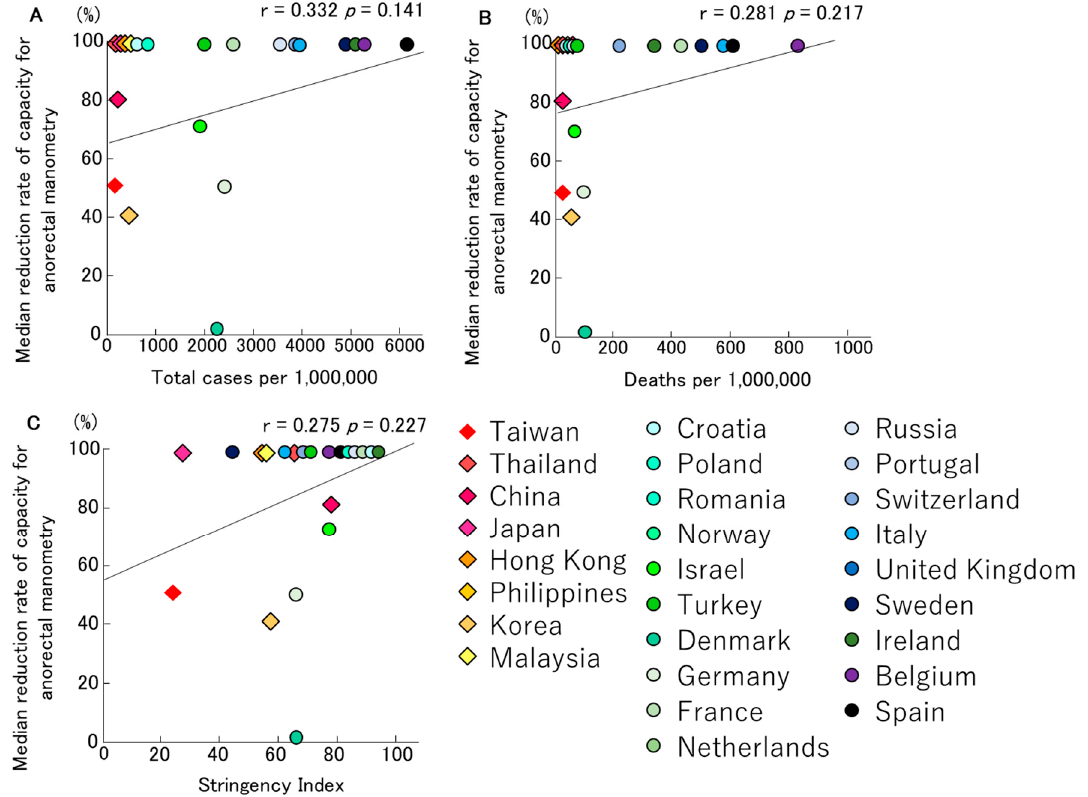
Figure 4. The relationships between median reduction rates of capacity for anorectal manometry, total infection rate ( A ) / mortality rate ( B ) for COVID-19 and Stringency Index ( C ) in Asian and European countries, are described. No significant trends were observed. Meanwhile, in Europe, anal manometry was stopped in countries with SARS-CoV-2 infection rates above 3000 per million people or with mortality rates above 200 per million people.